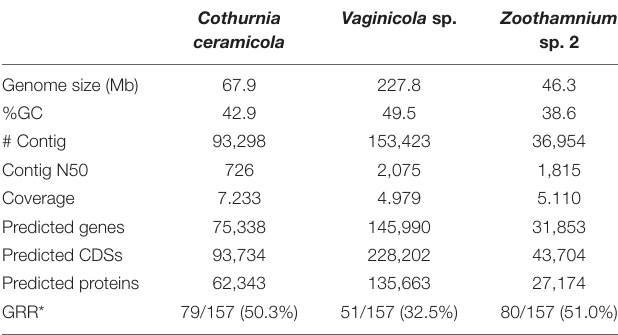
TABLE 1 | Information of single-cell genome